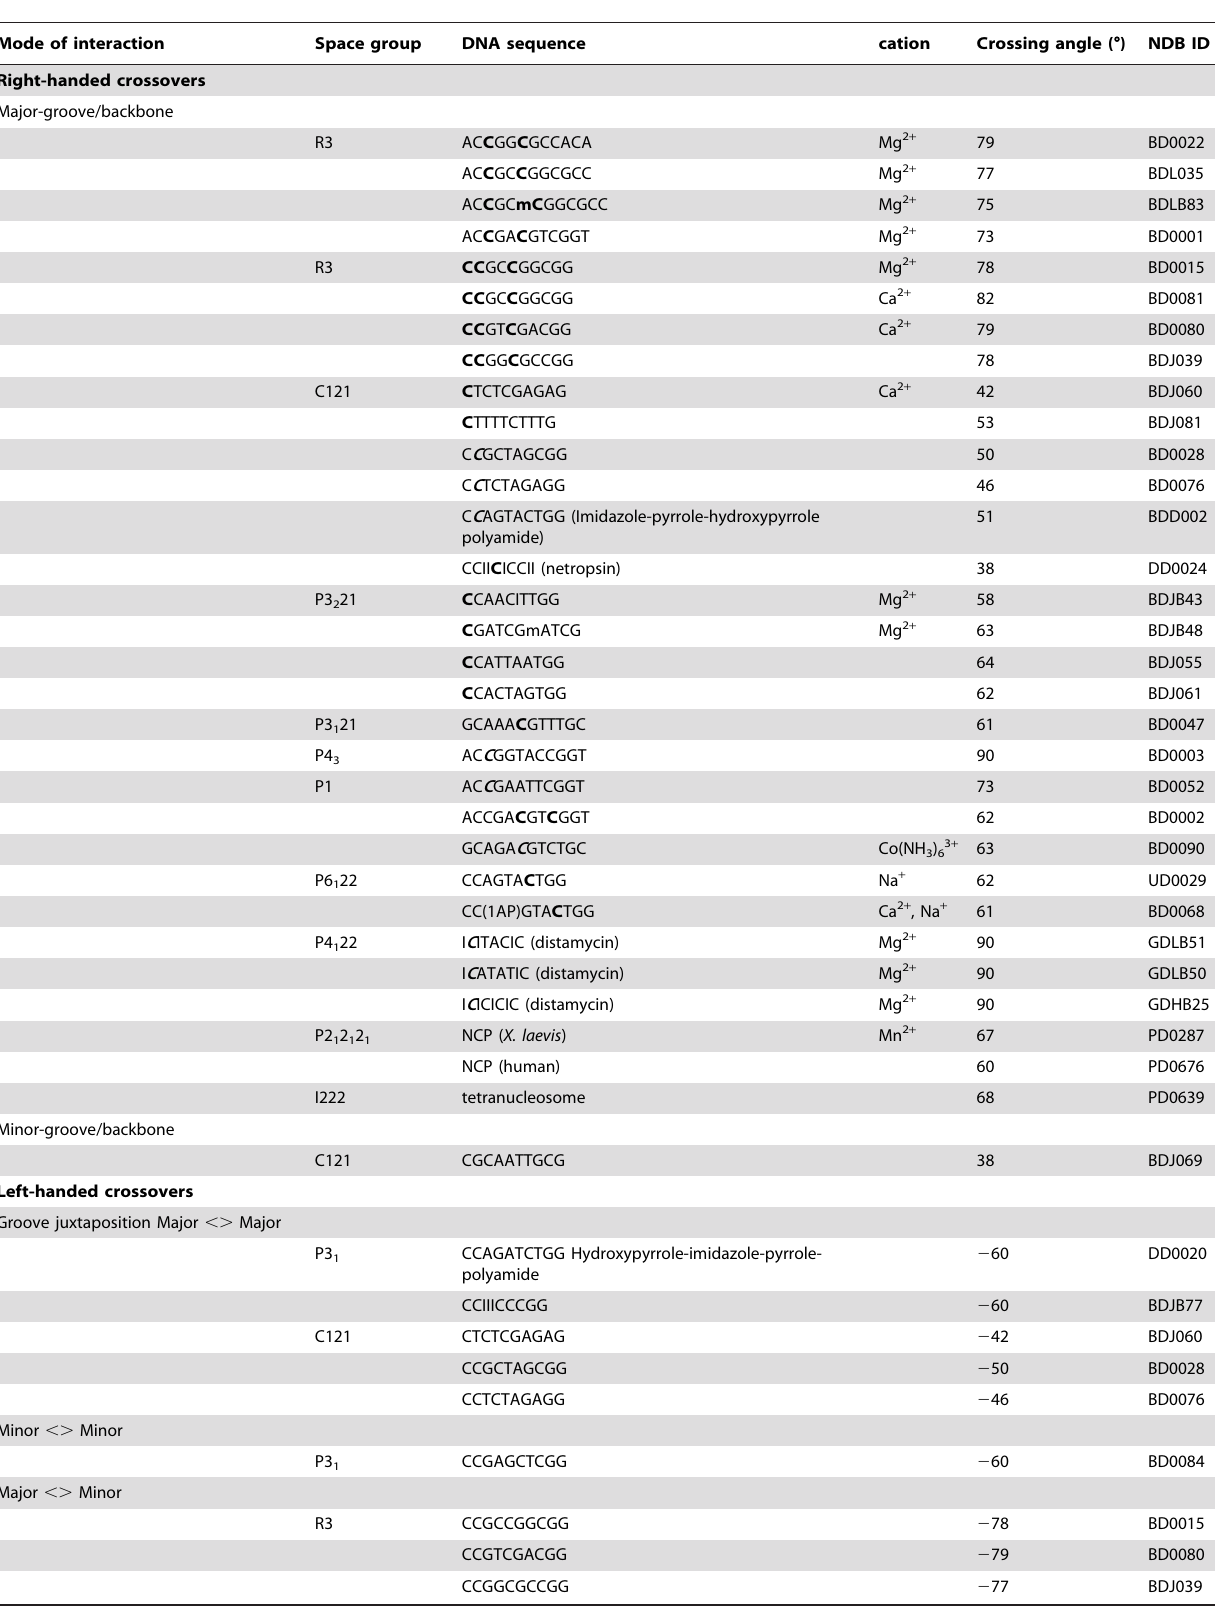
Table 1. Right- and left-handed crossovers in crystal structures of B-DNA duplexes and nucleosome core